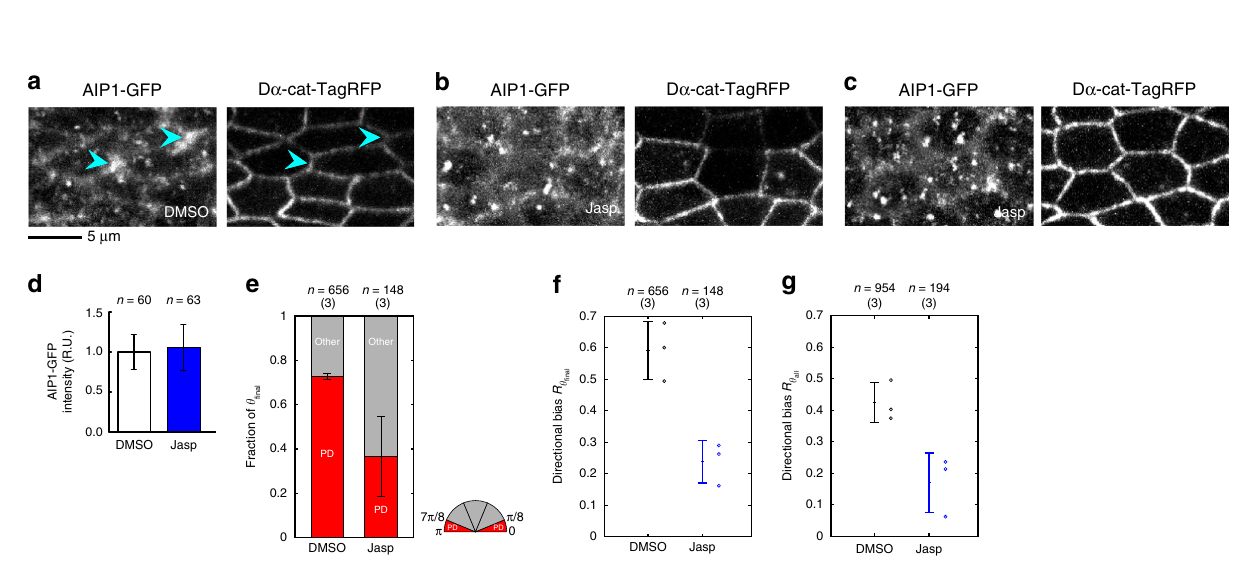
Fig. 3 AIP1 localizes to AP junctions in a tissue stretch-dependent manner. a , b Low magni fi cation images of DE-cad-GFP of the WT ( a ) and mechanically relaxed ( b ) wings at 24 h APF. The wing blade is shaded magenta. c AIP1-GFP (left) and D α -cat-TagRFP (right) in the mechanically relaxed wing at 24 h APF. d Directional bias of AIP1-GFP signal intensity (left) and D α -cat-TagRFP signal intensity (right) in the mechanically relaxed wing was quanti fi ed as described for Fig. 1b. e , f F-actin distribution in WT ( e ) and mechanically relaxed ( f ) wings at 24 h APF. Phalloidin (left) and DE-cad (right). Yellow and blue arrowheads indicate PD and AP junctions, respectively. g , h GFP-Ena in WT ( g ) and mechanically relaxed ( h ) wings at 24 h APF. Magenta arrowheads indicate the accumulation of GFP-Ena on cell vertices. i AIP1-GFP (left) in a pk 1 wing at 24 h APF. Cell contours are depicted (right). Blue arrowheads indicate AP junctions. j Directional bias of AIP1-GFP signal intensity in a pk 1 wing. k Left: Schematics of the wing. The expression domain of ptc-Gal4 was shaded gray. A square indicates the region shown in right. Right: The Fmi antibody signal in a fmi RNAi wing at 24 h APF. l AIP1-GFP (left) and D α -cat- TagRFP (right) in a fmi RNAi wing at 24 h APF. Blue arrowheads indicate AP junctions. The animal was carrying one copy of AIP1-GFP, and the brightness- contrast was adjusted using different parameters compared to those used in other homozygous samples. m Directional bias of AIP1-GFP signal intensity (left) and D α -cat-TagRFP signal intensity (right) in a fmi RNAi wing. The number of junctions examined is indicated ( d , j , m ). Data are presented as the